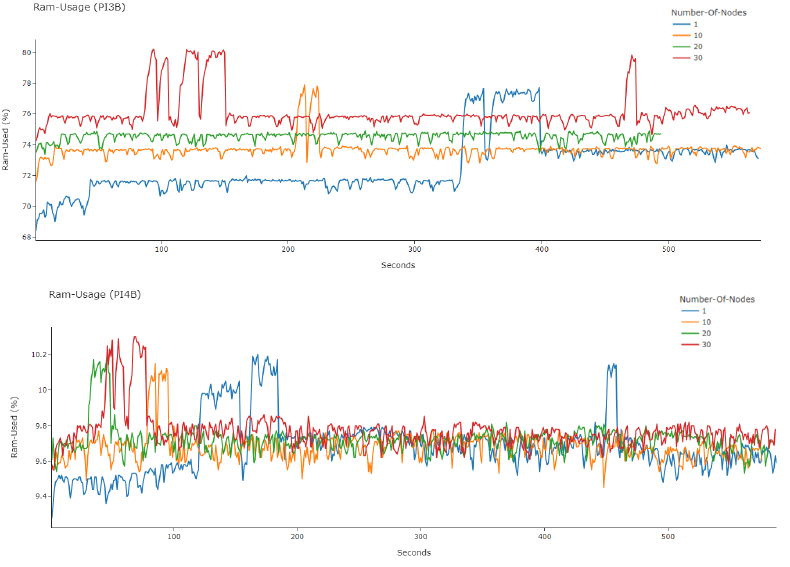
Figure 10. RAM usage on the Raspberry Pis 4B and 3B with each test